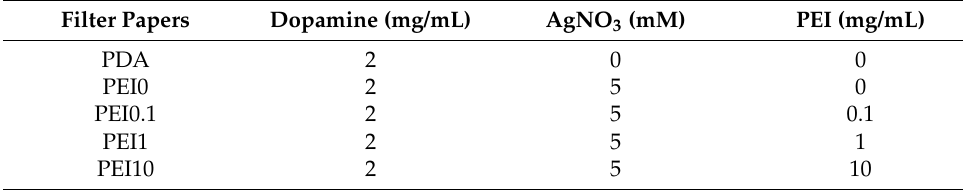
Table 1. The composition of the reaction